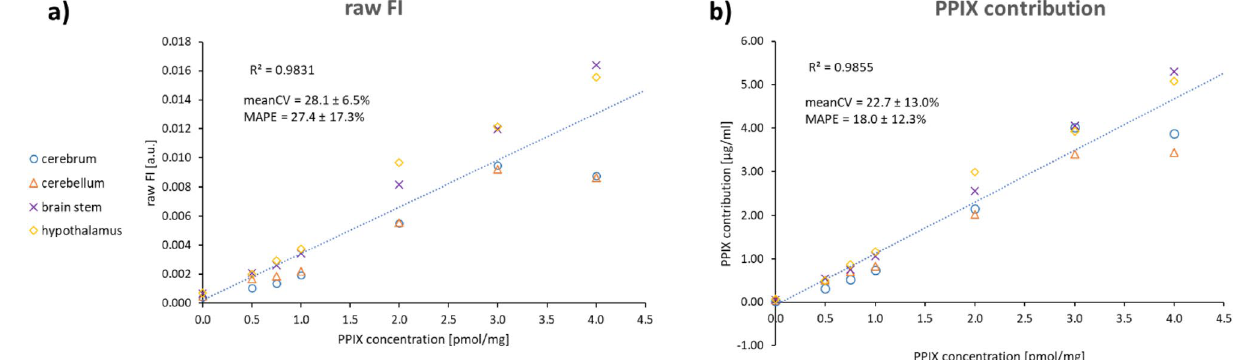
Figure 4. Results for the correlation of ( a ) raw fluorescence intensity (FI) and ( b ) calculated PPIX contribution [µg/ml] with known PPIX concentration [pmol/mg] (CV = coefficient of variation, MAPE = mean absolute percentage error, mean ± standard deviation) for all four investigated pig brain